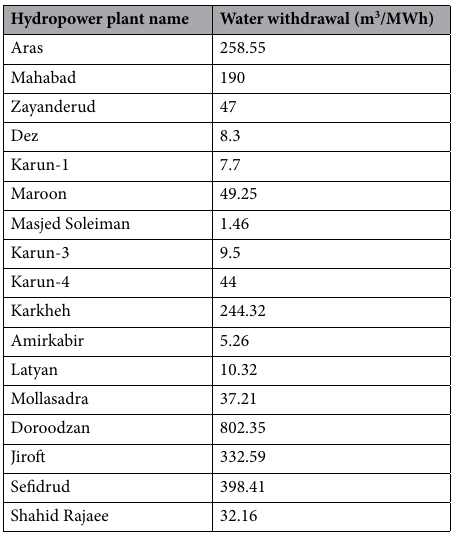
Table 13. Water withdrawal of Iranian hydropower plants 76 .